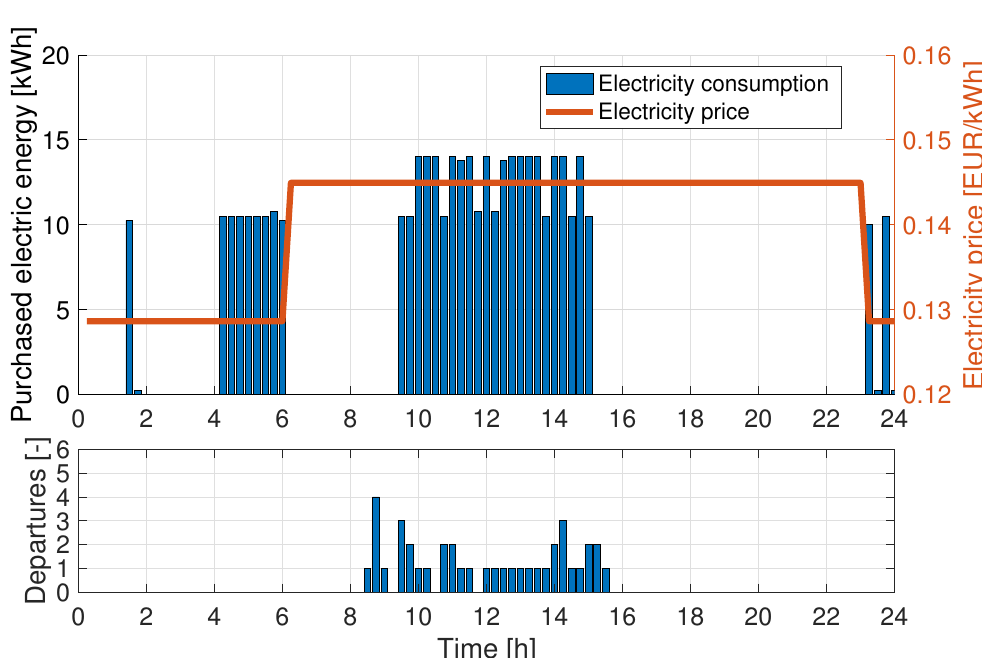
Figure 2. Energy expenditure (top) and departure schedule (bottom) at LIMB for the Most Demanding Day case (BPC